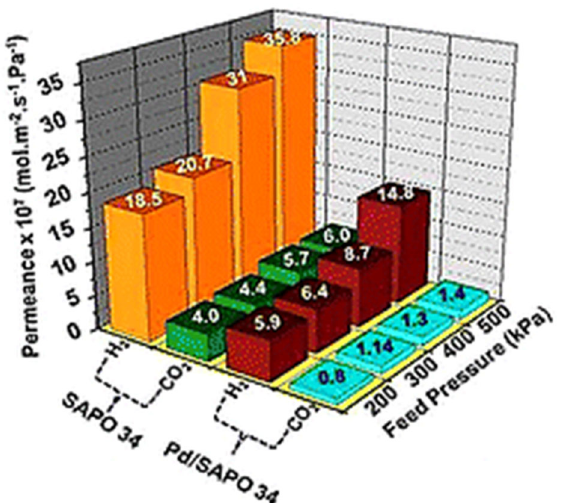
Figure 6. H 2 /CO 2 separation performance on Pd/SAPO-34 membranes. Adapted with permission from Ref. [108]. Copyright 2019 Royal Society of Chemistry.